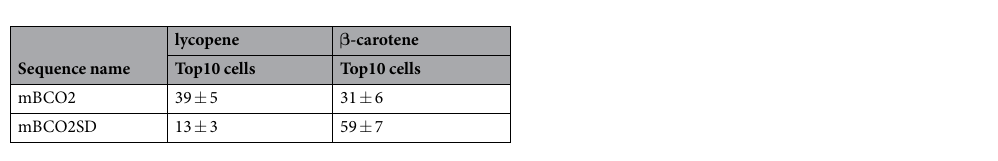
Figure 5. Comparison of β -carotene isomers dockings in model of Lancelet BCOLg and LanBCOc. ( A , C ) All - trans β -carotene (red) docked on the BCOLg model (green protein structure). All -trans β -carotene (yellow) docked on the lanBCOc model is superimposed on BCOLg model. ( B , D ) All- trans β -carotene (yellow) docked on the lanBCOc model (blue protein structure). All- trans β -carotene (red) docked on the BCOLg model is superimposed on the lanBCOc model.